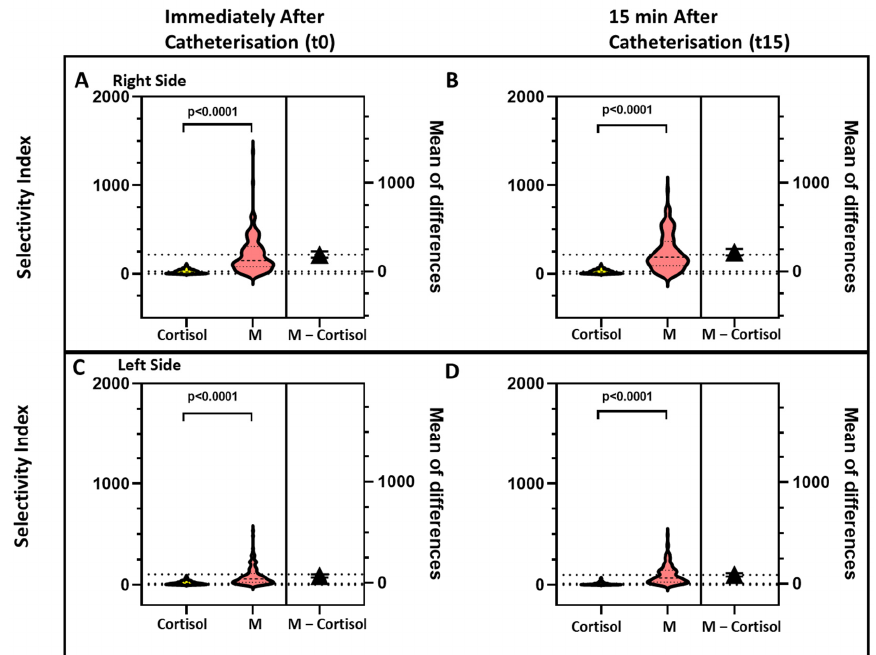
Figure 3. The violin plots show the values of the selectivity index for cortisol (SI C ) and metanephrine (SI M ), measured immediately after starting catheterization (Panels A and C ) and 15 min afterward (Panels B and D ), on the right side (Panels A and B ) and left side (Panels C and D ). For both sides and time points the SI M was higher than the SI C in a highly significant manner on both sides.